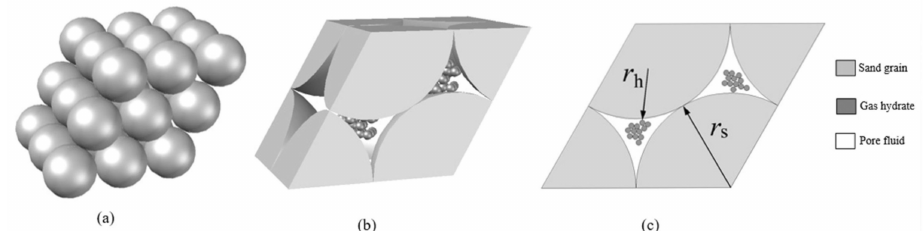
Figure 15. The oblique cubic model of hydrate particles occupying pore centers reprinted from [57] with permission from Elsevier. ( a ) The schematic diagram of a three-dimensional oblique accumula- tion structure; ( b ) a minimum unit of the oblique cubic model; ( c ) a side view.